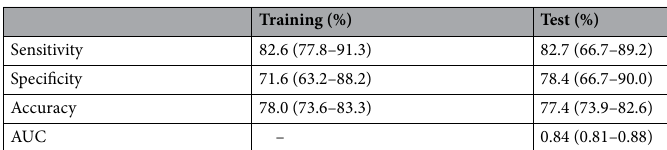
Table 6. Assessment of the predictive performance of the predictive model for training and testing data in multi-region radiomics analysis without the synthetic minority over-sampling technique. AUC area under the